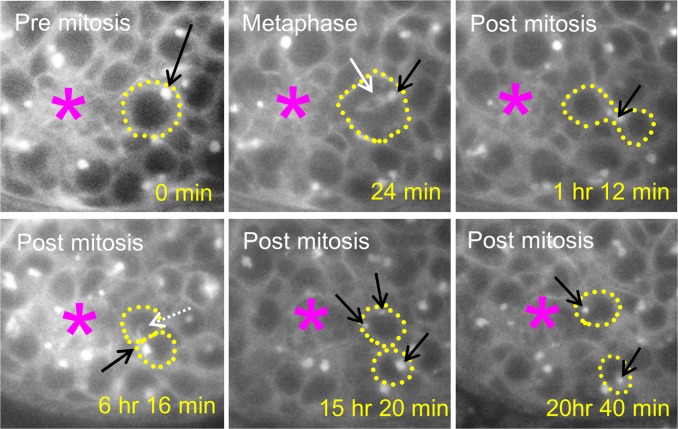
Spectrosome material is transferred via ring canal in GSCs.Spectrosome (Short Adducin-GFP) in wild type GSC is located in the basal position (0 min: interphase and 24min: metaphase). At 1hr 12min, spectrosome is co-localized with the ring canal structure. Spectrosome, together with ring canal structure, grows into the stem cell daughter at 6hr 16min, segregates into both daughter cells and form spectrosome-like structure again at 15hr 20 min. At 20hr 40 min, spectrosomes in both GSC and gonialblast further develop, and the gonialblast separates from GSC. Cellular boundaries and mitotic spindle are visualized with α-tub-GFP. Black arrow: spectrosome. White dash-arrow: spectrosome and/or ring canal tail. *: hub cells. Yellow dash-line: GSC or gonialblast boundary. Solid white arrow: mitotic spindle.